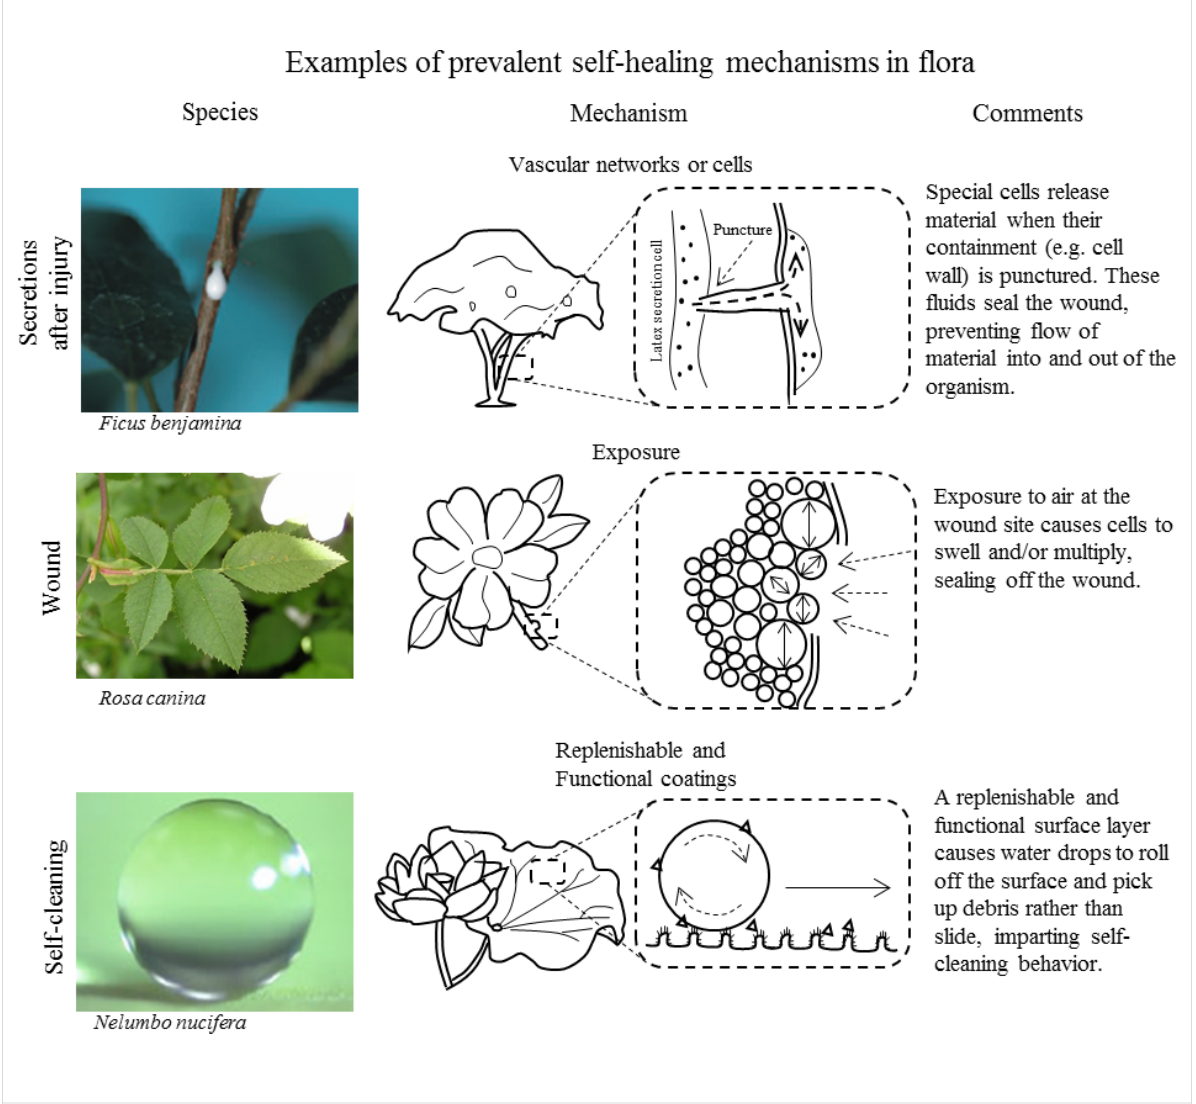
Figure 10: Examples of prevalent self-healing mechanisms found in plants showing vascular networks and cells of latex trees, wound healing through exposure in roses, and replenishable and functional coatings of lotus leaves. Each example is given with an illustration and description of the overall mechanisms. The top left image was reproduced with permission from [73], copyright 2010 WIT Press. The middle left image was reproduced from [78], copyright 2005 Michael Becker under CC-BY-SA 3.0 license (https://creativecommons.org/licenses/by-sa/3.0/). The bottom left image was repro- duced with permission from [32], copyright 2009 The Royal Society